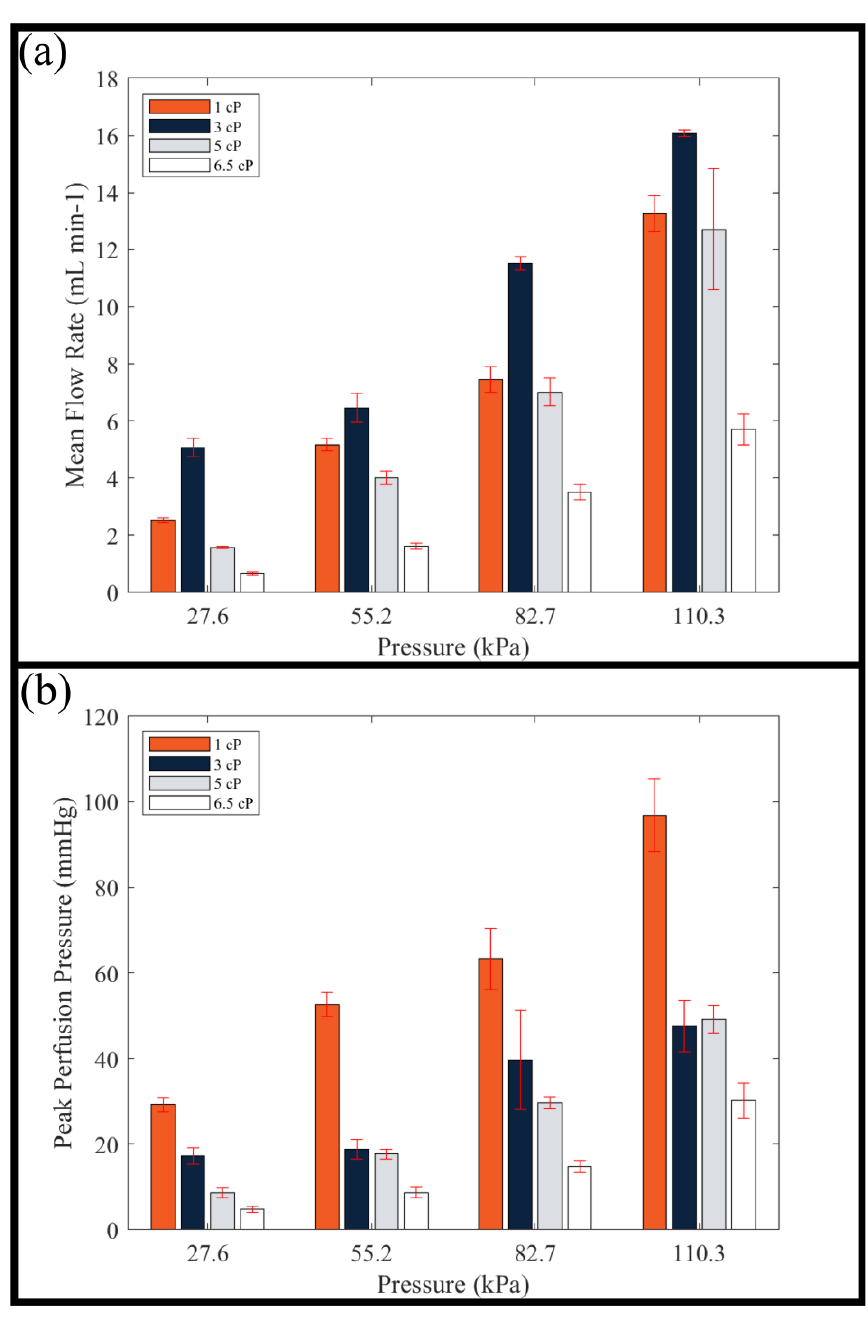
Figure 4. ( a ) Mean flow rate trend with increasing viscosity at each oxygen supply pressure. ( b ) Peak perfusion pressure with increasing viscosity at each oxygen supply pressure. At a viscosity of 1 cP, mean flow rates ranged between 2.5±0.10 to 13.2±0.63 mL/min at oxygen supply pressures between 27.6 to 110.3 kPa. Peak perfusion pressures varied between 29.3±1.67 and 96.8±8.42 mmHg. At equal oxygen supply pressures, the 3 cP viscosity had mean flow rates between 5.0±0.33 and 16.0±0.11 mL/min and peak perfusion